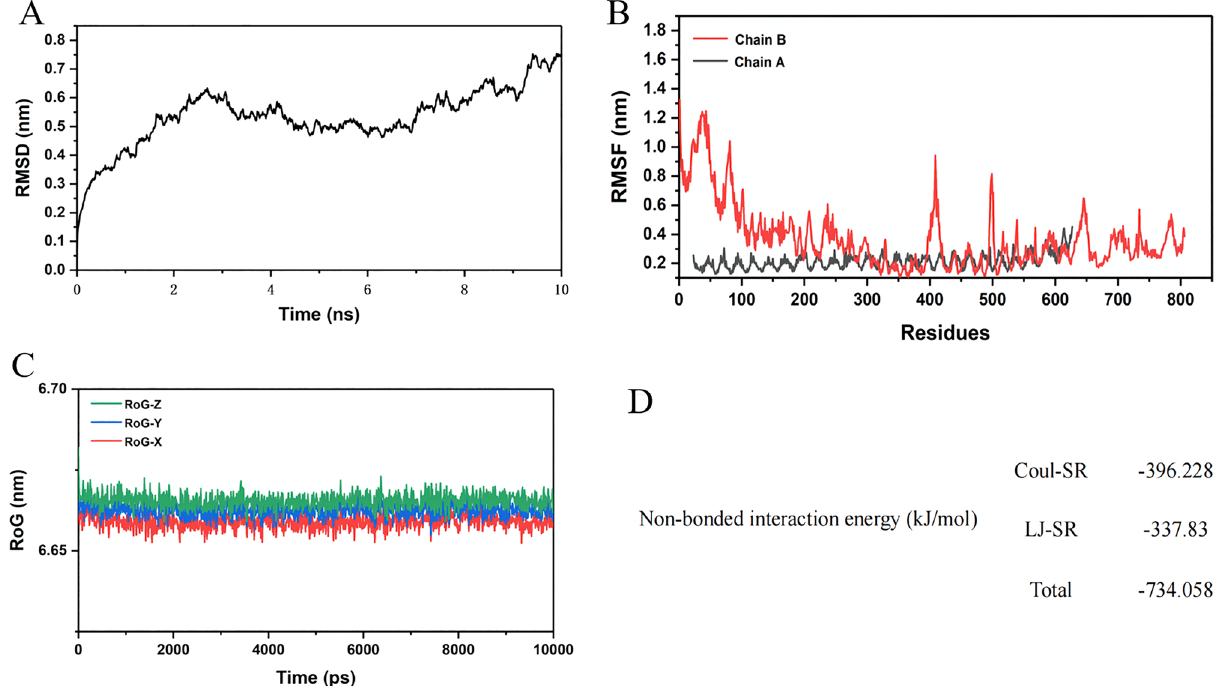
Figure 11. ( A–D ) The results of molecular dynamics simulation of the MEV-TLR4. ( A ) Root Mean Square Deviation analysis. ( B ) Root mean square fluctuation analysis. ( C ) The radius of gyration analysis. “Red” represents the X-axis direction, “blue” represents the Y-axis direction, and “green” represents the Z-axis direction. ( D ) Potential energy analysis that included Lennard–Jones short-range and Coulombic